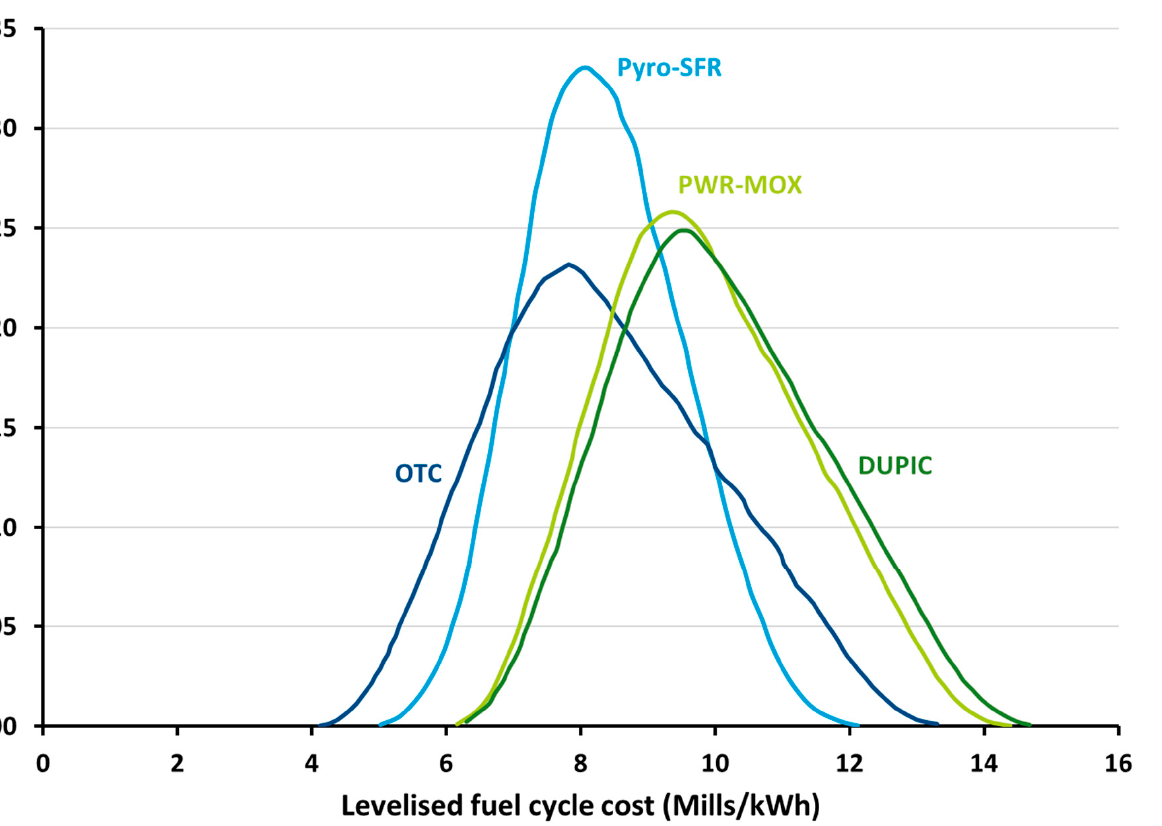
Table 8. LFCC calculations for fuel cycle scenarios analysed by Ko and Gao [40].